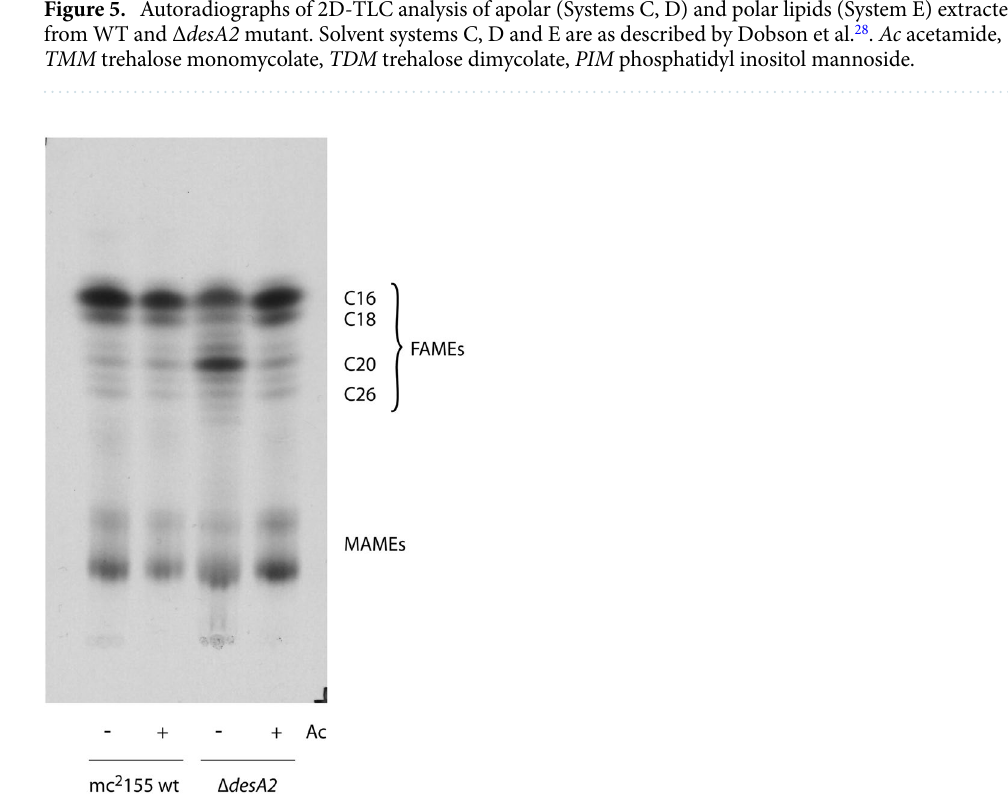
Figure 6. Autoradiograph of reverse phase TLC of [ 14 C]-labelled fatty acid methyl esters (FAMEs) and mycolic acid methyl esters (MAMEs) extracted from the ∆ desA2 mutant. Ac